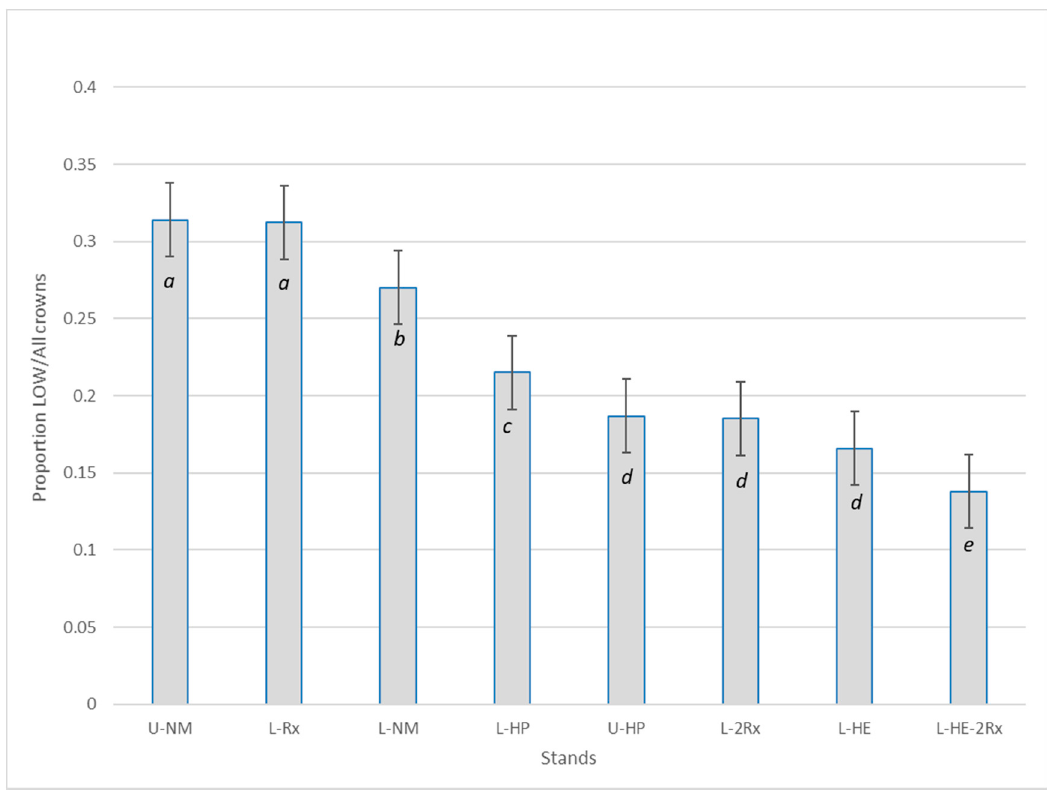
Table 7. Proportion of LOW RF-modeled individual tree crowns (ITCs) in upland and lowland sites. The proportion of LOW crowns was significantly different (two tailed Z-score tests of a pro- portion, p = 0.023) for the two site types. (Table 8). L-HE-2Rx had the lowest proportion of LOW trees, and L-Rx was the second highest in both the ‘RF model’ and ‘All trees’ assessments. The ‘All trees’ assessment ranked L-HP as the highest in proportion of LOW trees, while the RF model ranked U-NM as the highest. Otherwise, there was no consistency between the two methods.